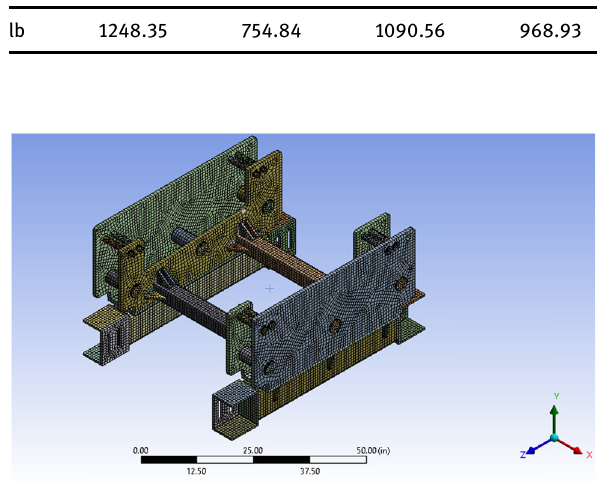
Figure 4: Fixture adapter design meshing in Ansys.